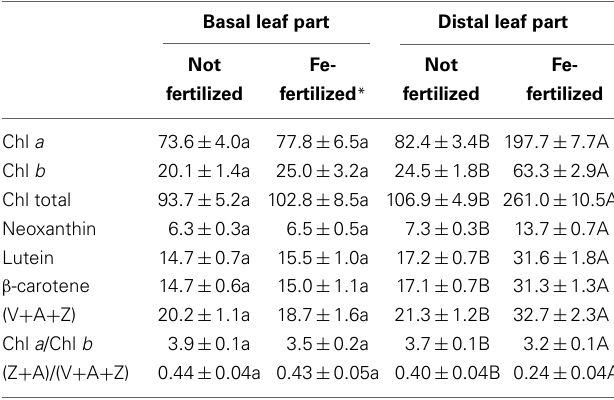
Table 3 | Concentrations of photosynthetic pigments (in μ mol m − 2 ; Chl a , Chl b , neoxanthin, lutein, β -carotene, and V + A + Z) and Chl a /Chl b and Z + A/(V + A + Z) ratios in basal and distal parts of Fe-deficient peach tree leaves either not fertilized or 8 weeks after the first treatment with 2mM FeSO 4 and 0.1% surfactant